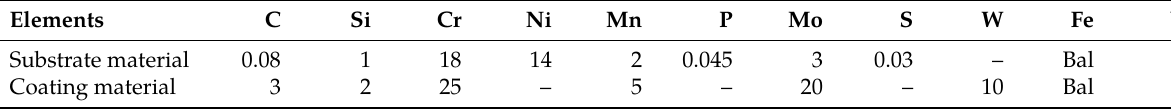
Table 1: Chemical composition (wt.%) of substrate and coating material. Elements